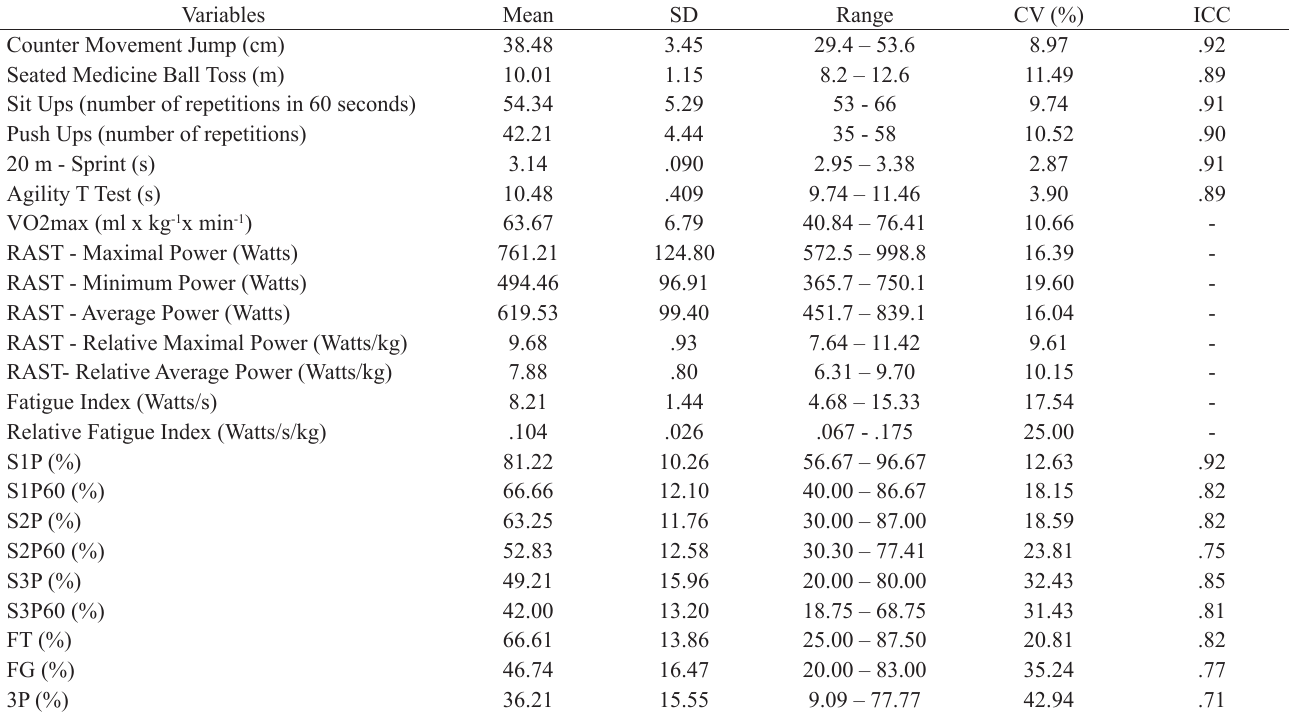
Table 2. Mean, standard deviation (SD), range, coefficient of variation (CV%) and interclass correlation coefficient (ICC) for physical performance measurement and basketball shooting accuracy of the perimeter basketball players ( n =